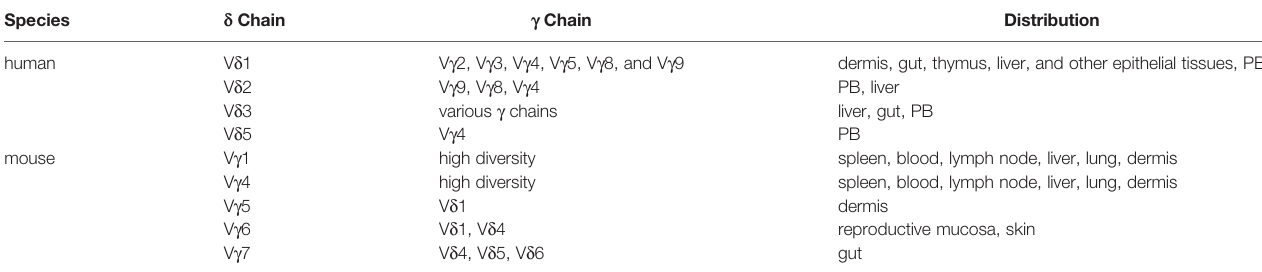
TABLE 1 | gd T subsets and distribution in human and mouse. Species d Chain